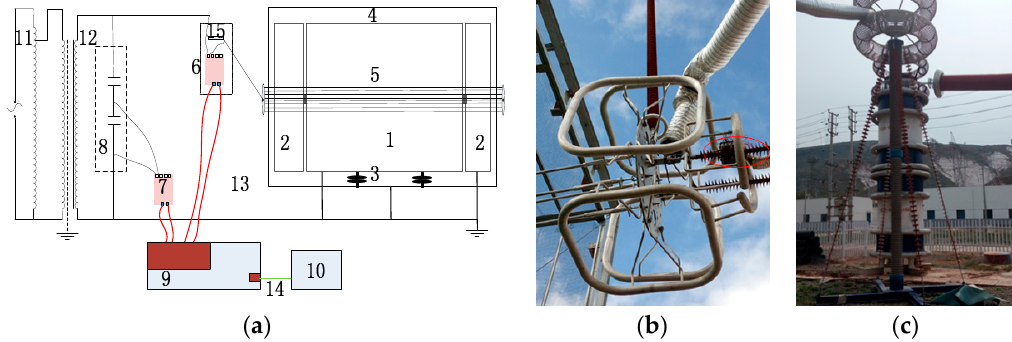
Figure 2. Measuring ends for current and voltage. ( a ) Sketch of the experimental platform: 1—Measuring section of the corona cage, 2—Protection sections of the corona cage, 3—Insulated support, 4—Shielding cage, 5—Test conductor, 6—Current measurement end, 7—Remote data acquisition module for communication at the voltage measurement end, 8-TRF-800 high-voltage standard voltage divider, 9—Local merging unit, 10—Host computer, 11—Voltage regulator, 12—Transformer, 13—Fibre-optic link, 14—Network cable, 15—Sampling resistor; ( b ) Current measuring end; ( c ) Voltage measuring end.